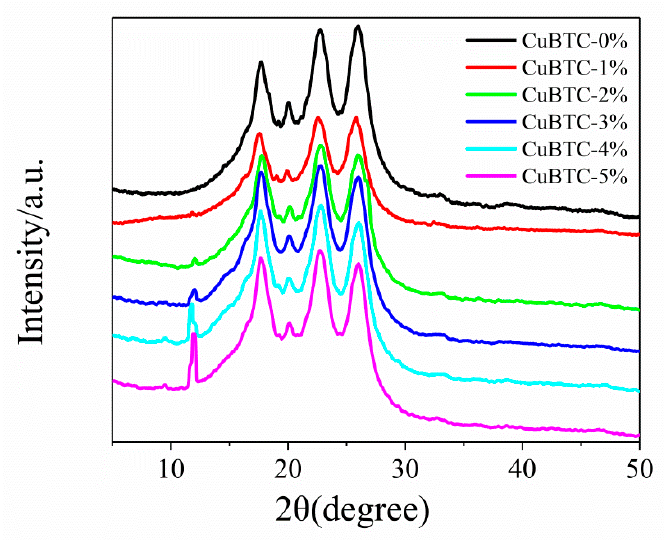
Figure 6. XRD patterns of the CuBTC-filled PEG MMMs.